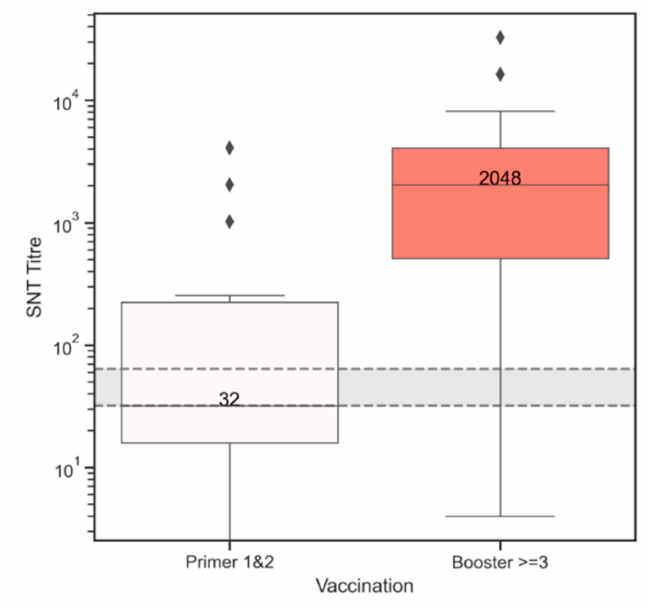
Figure 4. Box and whiskers plot of SNT titre results of horses, split into two groups. The Primer 1&2 group (white) consists of the SNT results from horses which have only received one or two vaccinations, and the Booster ≥ 3 group (salmon) consists of the SNT results from horses which have received three or more vaccinations. The black diamonds represent outliers above the 95th percentile. Each box shows 25th to 75th percentile; whiskers go between the 5th percentile at the bottom and the 95th percentile at the top. The grey band is between titres 32 and 64 which has been considered a protective titre in previous studies [9].